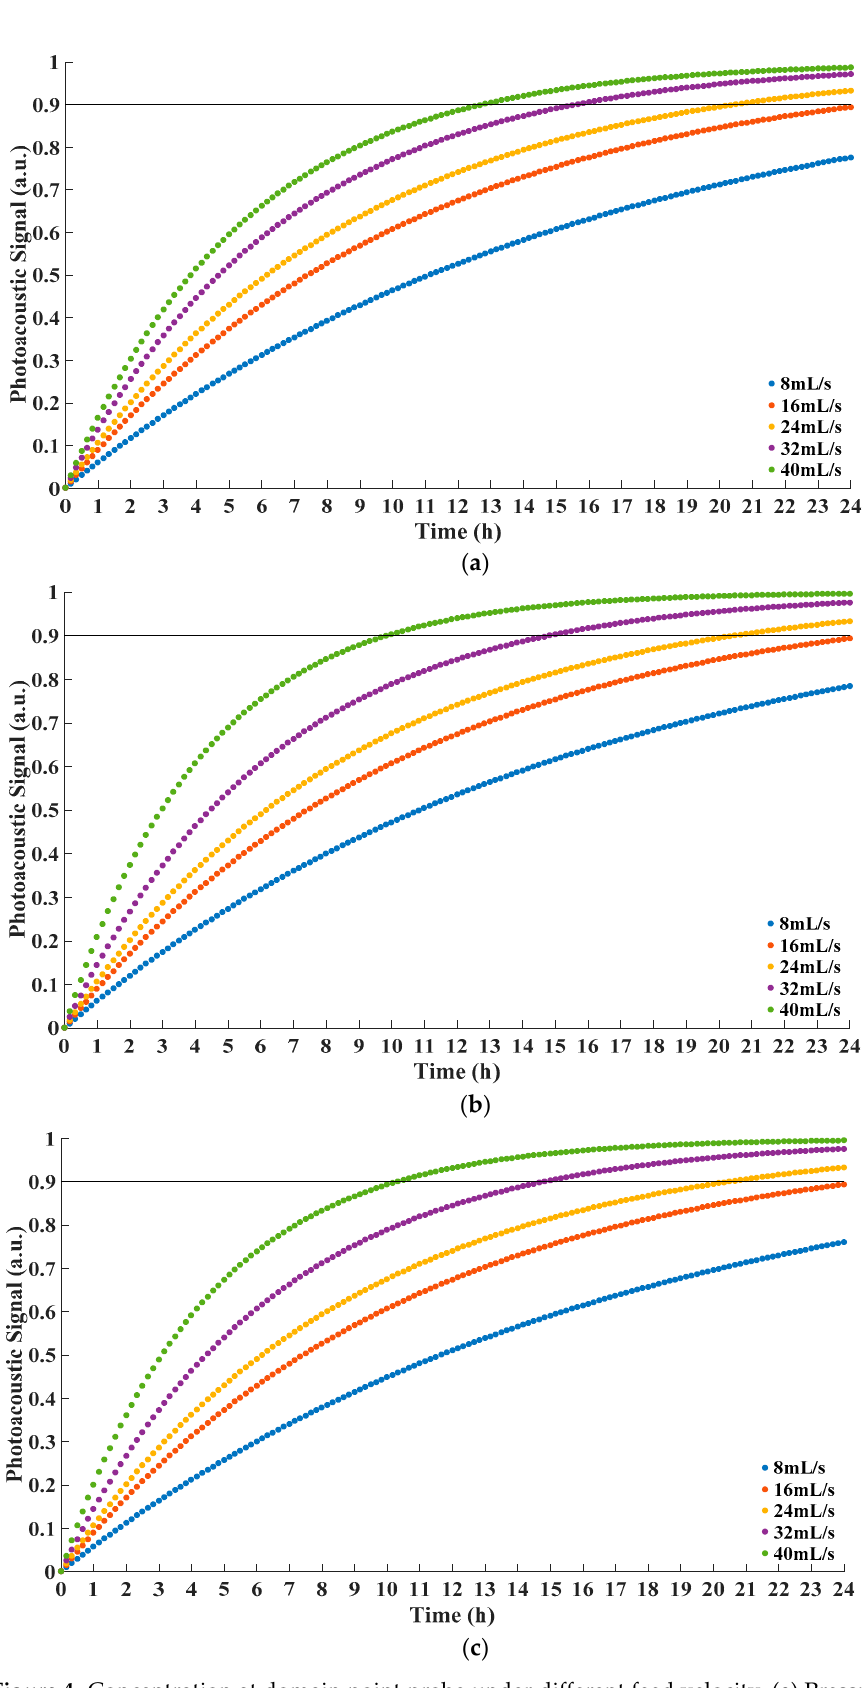
Figure 4. Concentration at domain point probe under different feed velocity. ( a ) Pressure 1.0 atm; ( b ) Pressure 1.5 atm; ( c ) Pressure 2.0 atm.